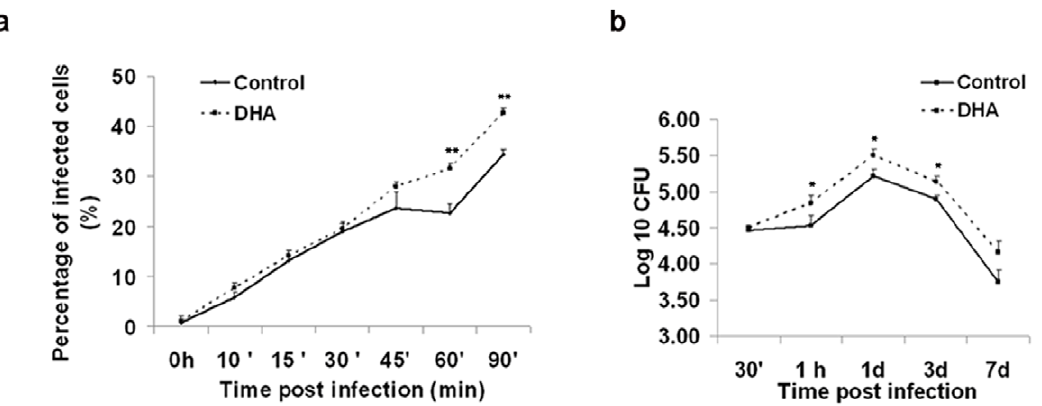
Figure 4. DHA reduces mycobacterial phagolysosome maturation in IFN c -primed J774A.1 cells. Cells were incubated with 50uM DHA for 24 h and infected with20 MOI GFP-expressing M. tuberculosis for 1 h. Cells were seeded at a density of 500,000 cells/well. Phagolysosome maturation was defined based on acquisition of lysotracker by GFP- Mtb -containing phagosomes and visualized by fluorescent microscopy, as described in the Materials and Methods . a–b. Representative images of the reduced colocalization induced by DHA, compared to Control. Data representative of three independent experiments. c. Percentages of Lysotracker-, LAMP-1, LAMP3-, Rab5-, Rab7-positive mycobacterial phagosomes. Data represent the percentage of colocalization (mean 6 SEM; n=5). * Indicates a significant effect of DHA compared to mock control, *p , 0.05, **p , 0.01. Abbreviations used: DHA, docosahexaenoic acid; LAMP-1, lysosomal-associated membrane protein.